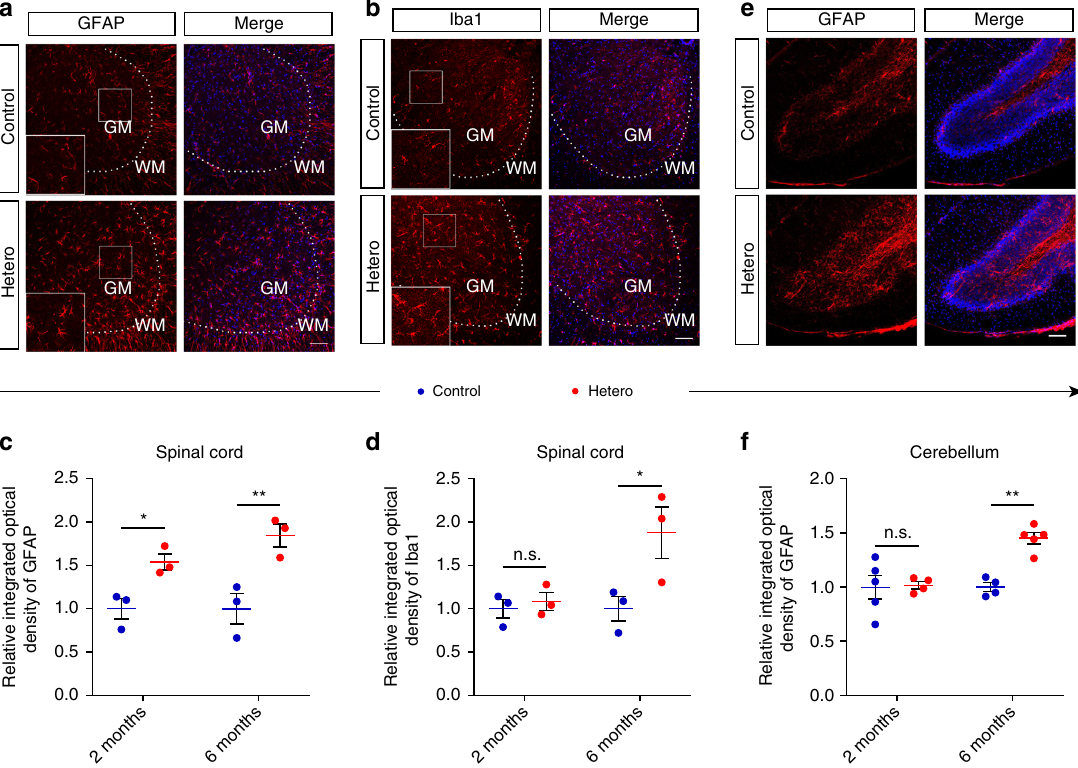
Fig. 6 Gliosis in the lumbar spinal cord and cerebellum of GFP-PR 28 heterozygous mice. a Representative images showing the numbers of GFAP-positive astrocytes in the lumbar spinal cord of 6-month-old control and GFP-PR 28 heterozygous mice. GM (gray matter), WM (white matter). White squares are enlarged views of corresponding images. GFAP (red), Hoechst (blue). Scale bar represents 100 μ m. b Representative images showing the numbers of Iba1- positive microglia in the lumbar spinal cord of 6-month-old control and GFP-PR 28 heterozygous mice. GM (gray matter), WM (white matter). White squares are enlarged views of corresponding images. Iba1 (red), Hoechst (blue). Scale bar represents 100 μ m. c Relative integrated optical density of GFAP in the lumbar spinal cord of control and heterozygous mice at 2 and 6 months of age. Two-way ANOVA, Bonferroni post hoc test; 2 months, n = 3, 3 mice; 6 months, n = 3, 3 mice. d Relative integrated optical density of Iba1 in the lumbar spinal cord of control and heterozygous mice at 2 and 6 months of age. Two-way ANOVA, Bonferroni post hoc test; 2 months, n = 3, 3 mice; 6 months, n = 3, 3 mice. e Representative images showing the numbers of GFAP- positive astrocytes in the cerebellum of 6-month-old control and GFP-PR 28 heterozygous mice. GFAP (red), Hoechst (blue). Scale bar represents 100 μ m. f Relative integrated optical density of GFAP in the cerebellum of control and heterozygous mice at 2 and 6 months of age. Two-way ANOVA, Bonferroni post hoc test; 2 months, n = 5, 4 mice; 6 months, n = 4, 5 mice. All data are displayed as mean ± s.e.m. * P < 0.05, ** P < 0.01, n.s. not signi fi